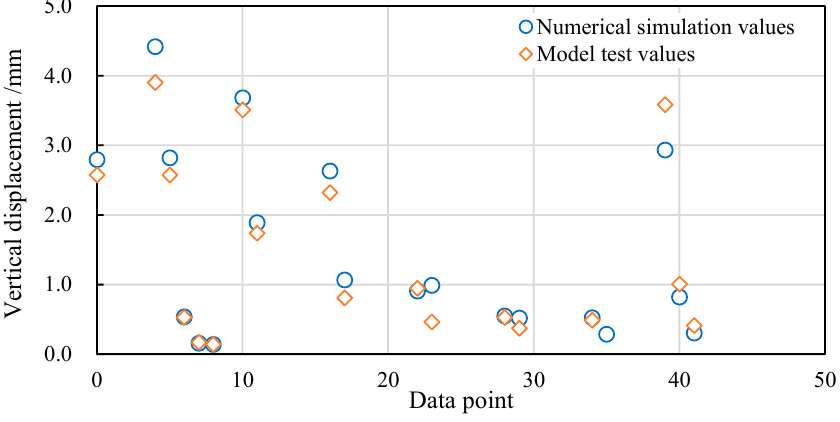
Figure 18. Vertical displacement of different data points.